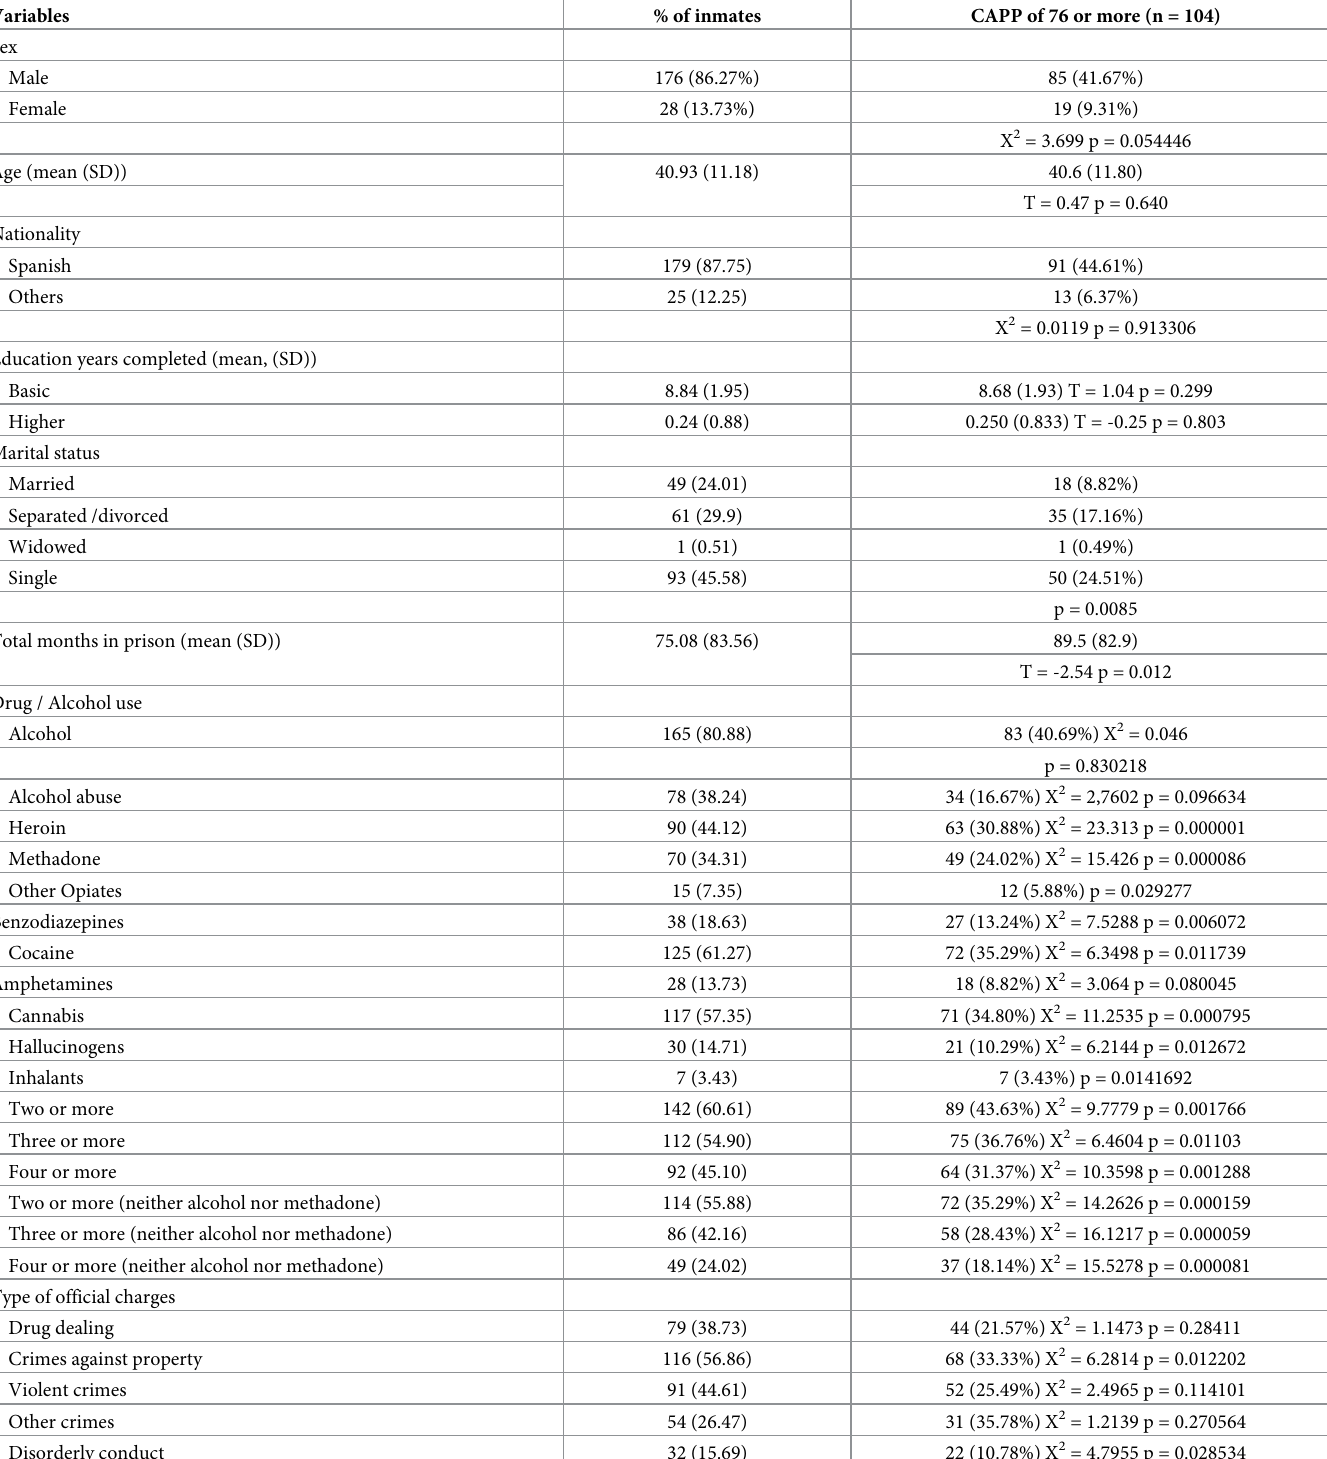
Table 1. IPDE scores, sociodemographic and forensic variables of the sample. Levels of significance for these variables in relation to an arbitrary CAPP cut-off score of 76 (the sample mean) are also